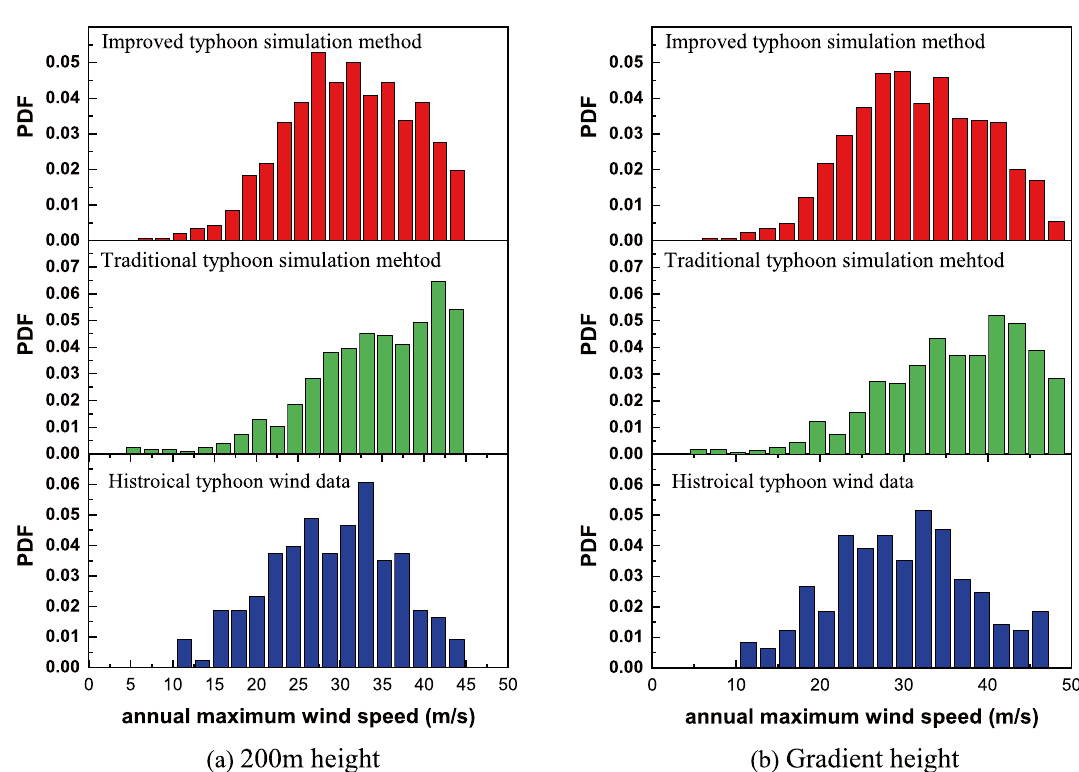
Figure 1. Comparison of probability distribution of annual maximum wind